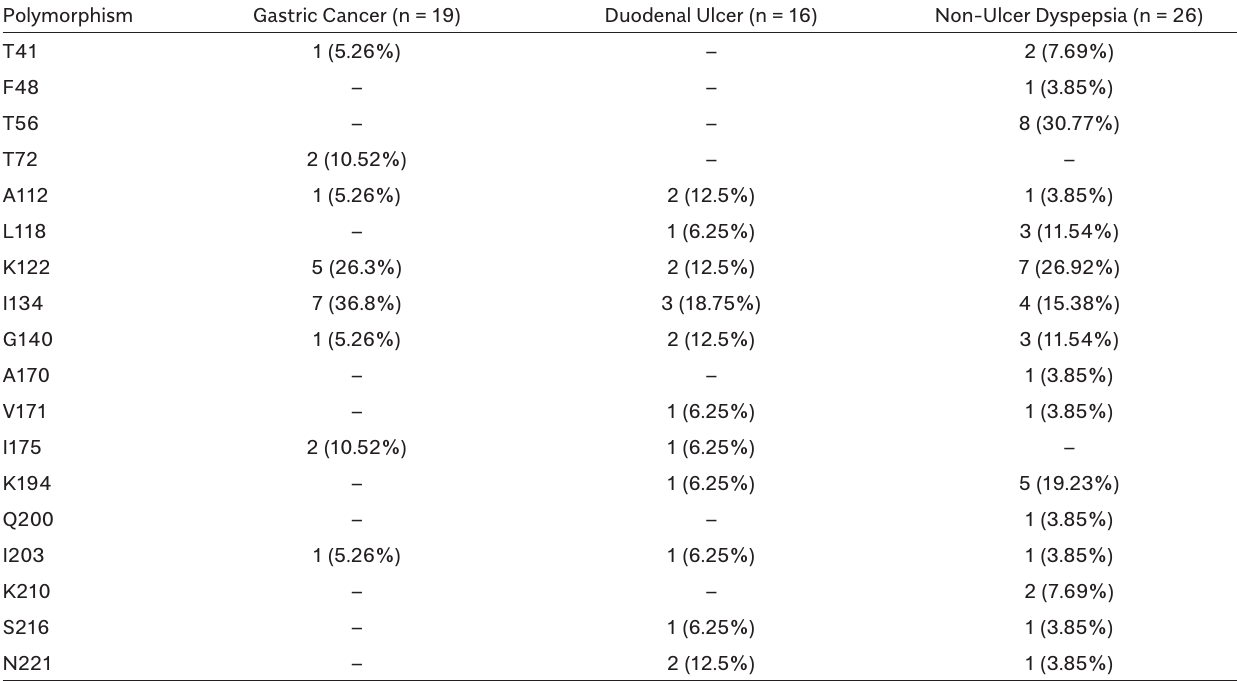
Supplementary Table 1. Polymorphisms Other Than the Polymorphisms of CagLHM